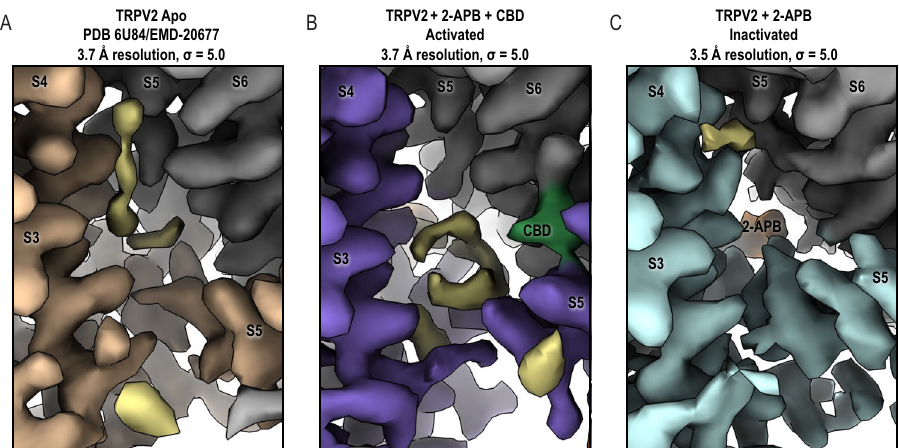
Fig. 5 Expulsion of the lipid from the vanilloid pocket of TRPV2 upon 2-APB binding. A The vanilloid pocket of TRPV2 Apo1 (PDB 6U84) contains well- resolved lipid tails. B TRPV2 2APB_CBD_AC has disrupted lipid density in the vanilloid pocket. C TRPV2 2APB_IAC displays minimal density that could be attributed to the lipid tails in the vanilloid pocket. One monomer is colored wheat, medium purple or light cyan, the adjacent monomer is colored gray; 2-APB is colored orange, CBD is colored green, potential lipid densities are colored khaki. Maps contoured at σ